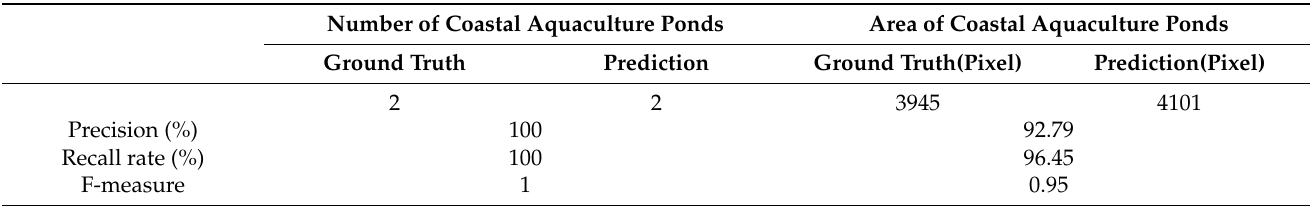
Table 4. Accuracy evaluation of coastal aquaculture ponds extraction in Qushan Island,